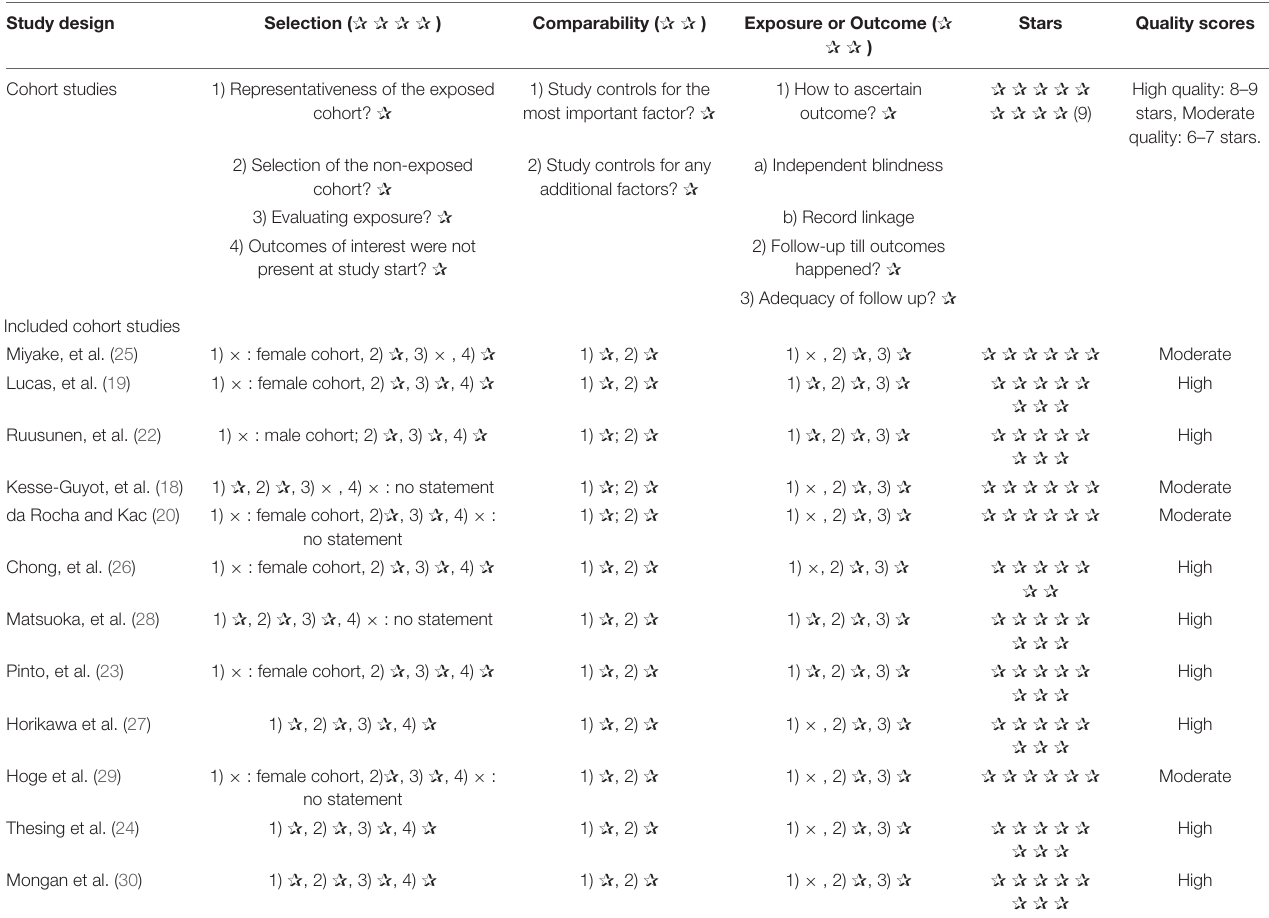
TABLE 2 | Quality assessment of the included cohort studies. Study